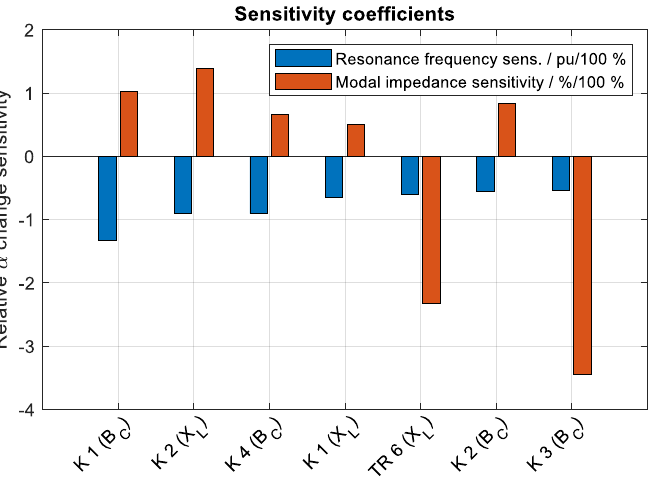
Figure 7. Resonance sensitivity coefficients of mode 5. Table 3. Resonance sensitivity coefficients of mode 5.